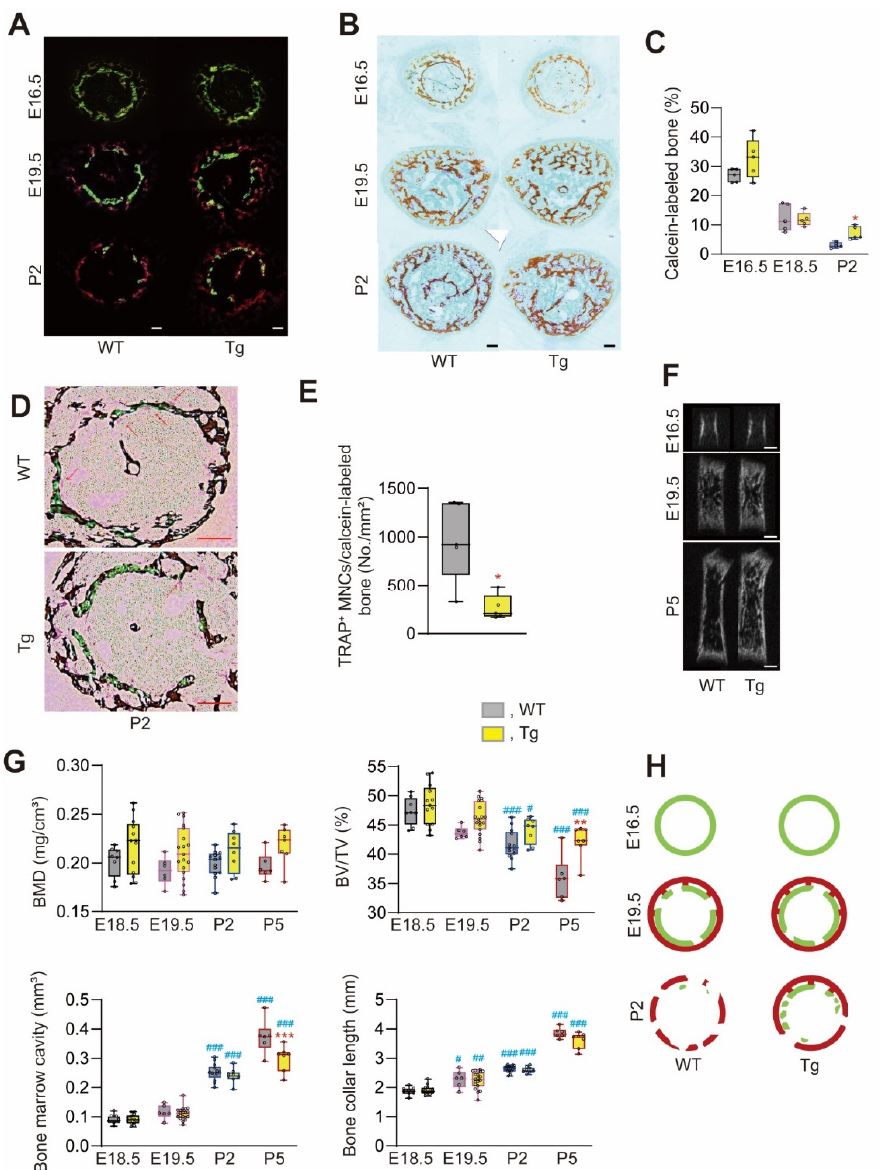
eosin (H-E) ( A ) and hematoxylin and Alcian blue ( B ). Scale bars, 500 μ m. ( C ) High magnification images of the boxed areas (P5) in panel ( B ). Scale bars, 80 μ m.